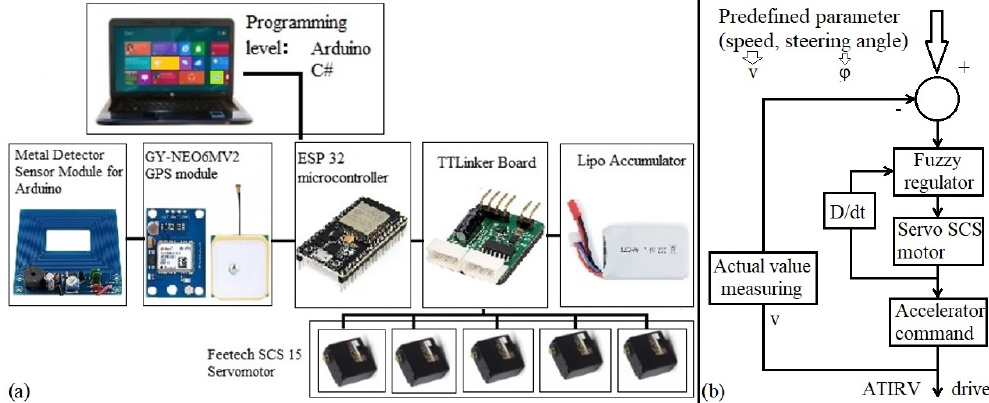
Figure 1. Simplified structure of the physical components ( a ) and the control algorithm ( b ) for all-terrain intelligent robotic vehicles (ATIRVs).